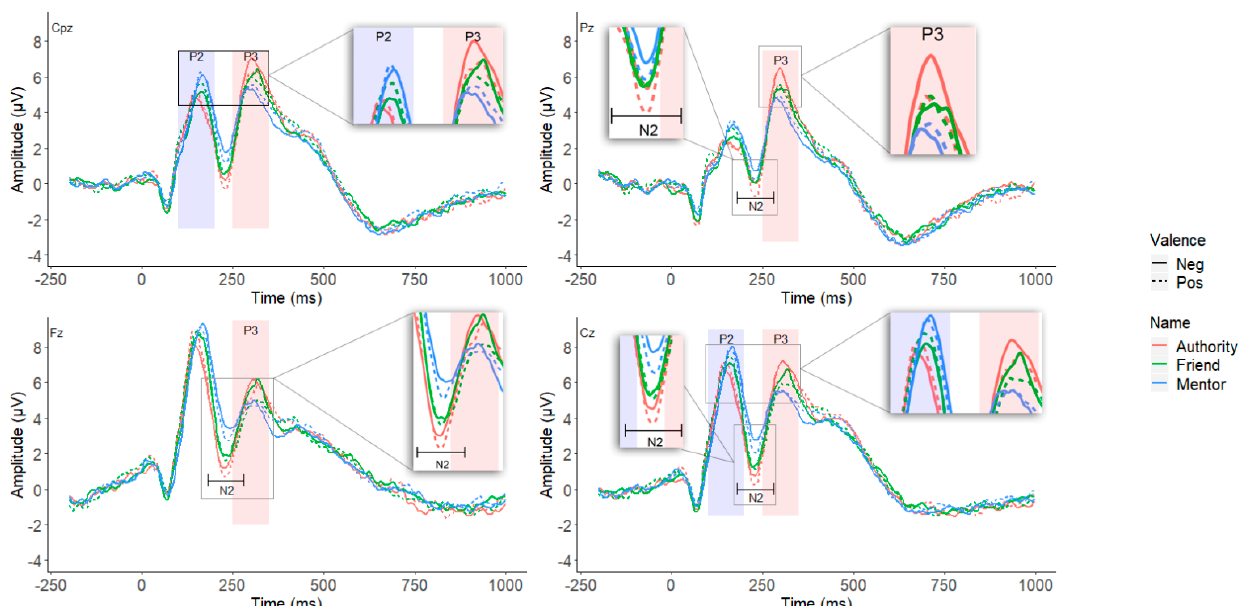
Figure 2. Grand average ERPs of the P2, N2 and P3 components at the indicated electrode sites. Mentor Authority Friend